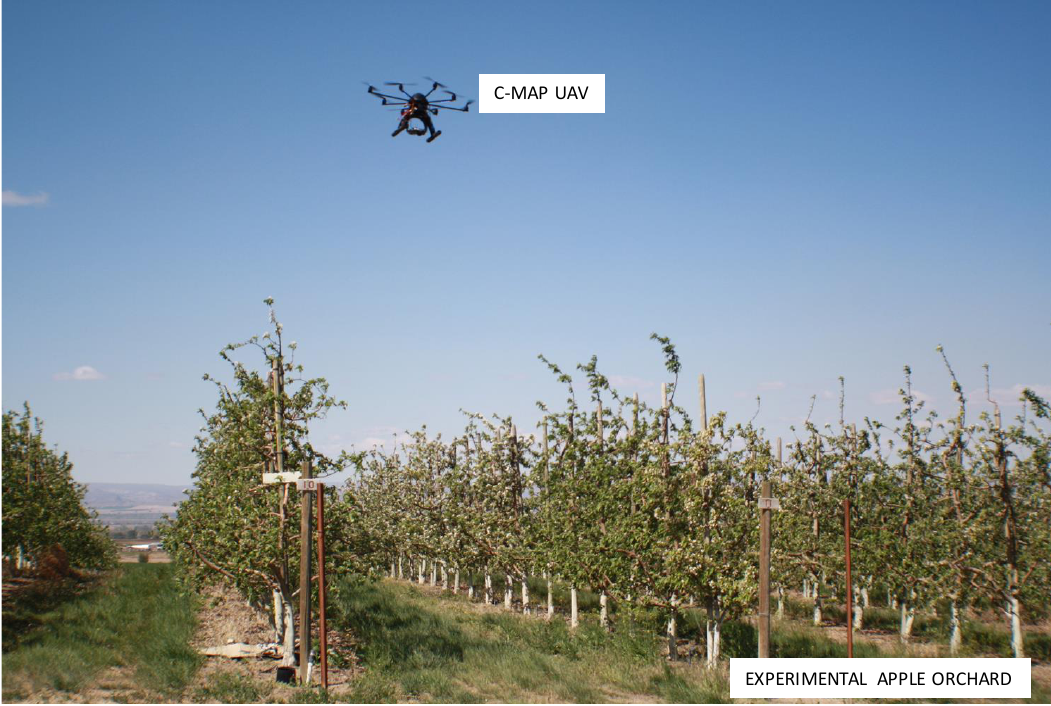
Figure 4. Unmanned aerial vehicle acquiring images over experimental orchard.